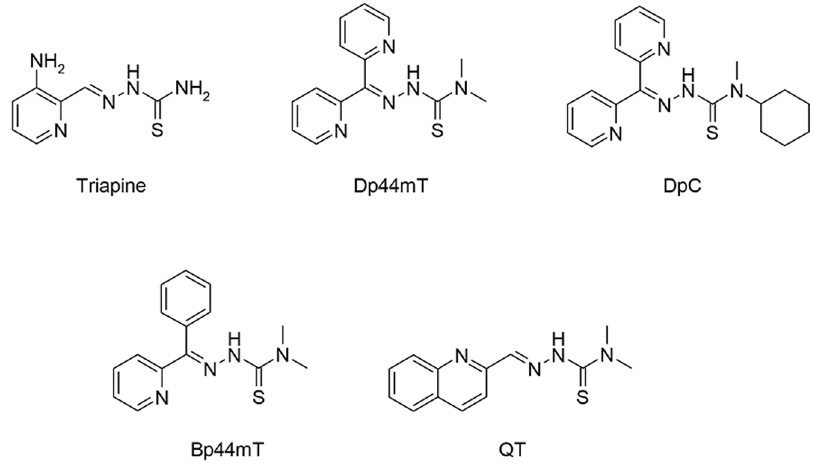
Figure 1. Chemical structures of the chelators, Triapine, di-2-pyridylketone 4,4-dimethyl-3-thiosemicarbazone (Dp44mT), di-2- pyridylketone 4-cyclohexyl-4-methyl-3-thiosemicarbazone (DpC), 2-benzoylpyridine 4,4-dimethyl-3-thiosemicarbazone (Bp44mT) and quinoline thiosemicarbazone (QT).